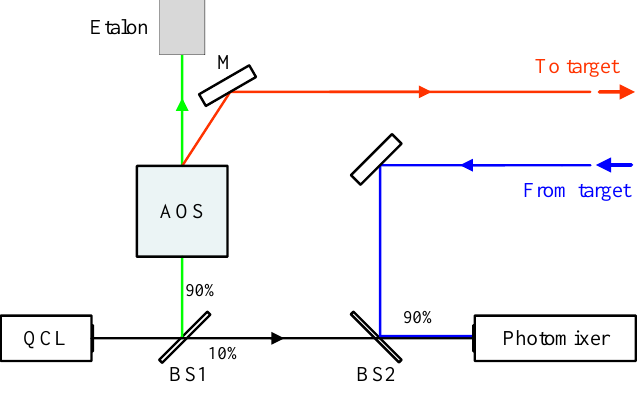
Figure 11. Optical layout of the ACLaS. M, mirror; BS, beam splitter; AOS, acousto-optic shifter [212].